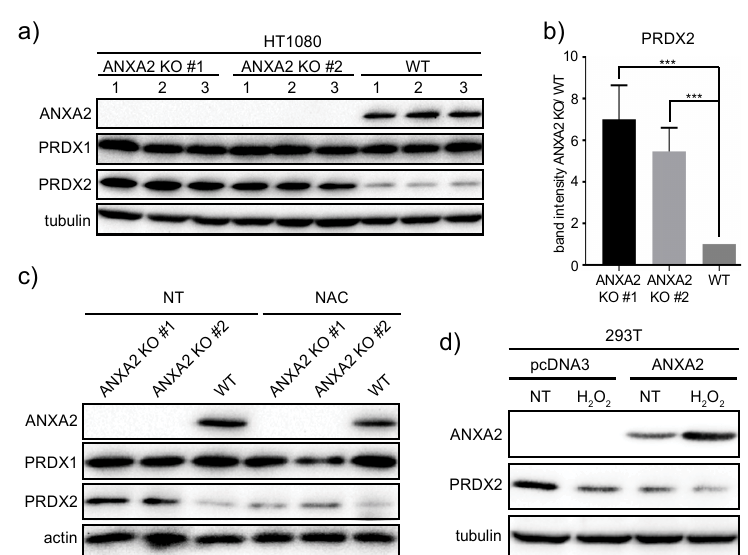
Figure 3. ANXA2 regulates PRDX2 expression in a ROS dependent way. ( a ) HT1080 ANXA2 knockout or WT cells were grown in complete media until 80% confluency. After what cells were lysed and 20 µg of each protein extract was subjected to SDS-PAGE, transferred onto nitrocellulose membranes and analyzed by western blotting with the antibodies indicated. Cells were loaded in triplicates; ( b ) Quantification analysis of PRDX2 immunoblots from ( a ). Quantification was performed using Image J software. Tubulin immunoblot was used as a loading control for normalization of the quantification. Error bars represent Standard Deviations. Statistical analysis was evaluated using two-tailed Student’s t -test. In every case a p -value of less than 0.05 (*), less than 0.01(**) and 0.001 (***) was considered statistically significant; ( c ) HT1080 ANXA2 knockout sub-populations (ANXA2 KO #1; ANXA2 KO #2) or wild-type (WT) cells were grown in complete media either not supplemented (left panel) or supplemented with 5 mM NAC (right panel) for 48 h. After what cells were lysed and 20 µg of each protein extract was subjected to SDS-PAGE, transferred onto nitrocellulose membranes and analyzed by western blotting with the antibodies indicated; ( d ) 293T cells were transiently transfected with either pcDNA3 (empty) vector or pcDNA3-ANXA2 plasmids as indicated in the figure. 24 h after transfection these cells were either not treated or treated with 100 µM of H 2 O 2 for 24 h. Cells were then lysed and 20 µg of each protein extract was subjected to SDS-PAGE, transferred onto nitrocellulose membranes and analyzed by western blotting with the antibodies indicated. Results are representative of three independent experiments ( n = 3).